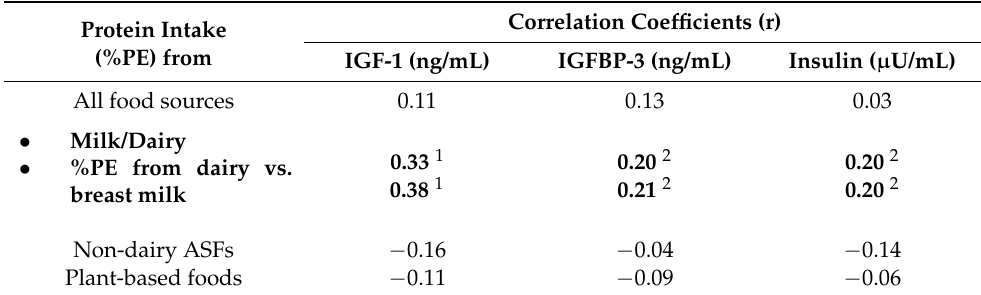
Table 6. Pearson’s correlation between %PE at 9–12 months and blood levels of IGF-1, IGFBP-3 and insulin at 12 months of age.